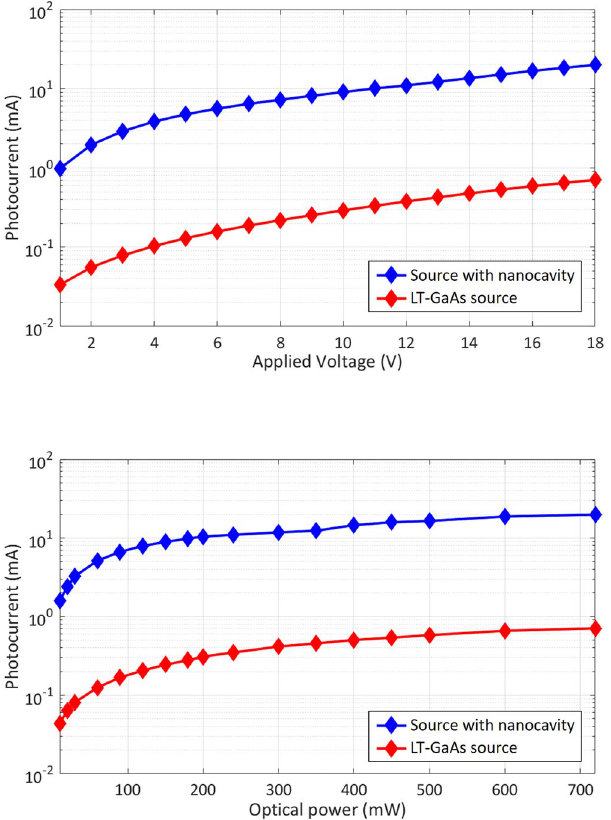
Figure 5. ( a ) Photocurrents in the nanocavity-based terahertz source and the terahertz source fabricated on the LT-GaAs substrate as a function of the bias voltage under an optical pump power of 720 mW. ( b ) Photocurrents in the nanocavity-based terahertz source and the terahertz source fabricated on the LT-GaAs substrate as a function of the optical pump power under a bias voltage of 18